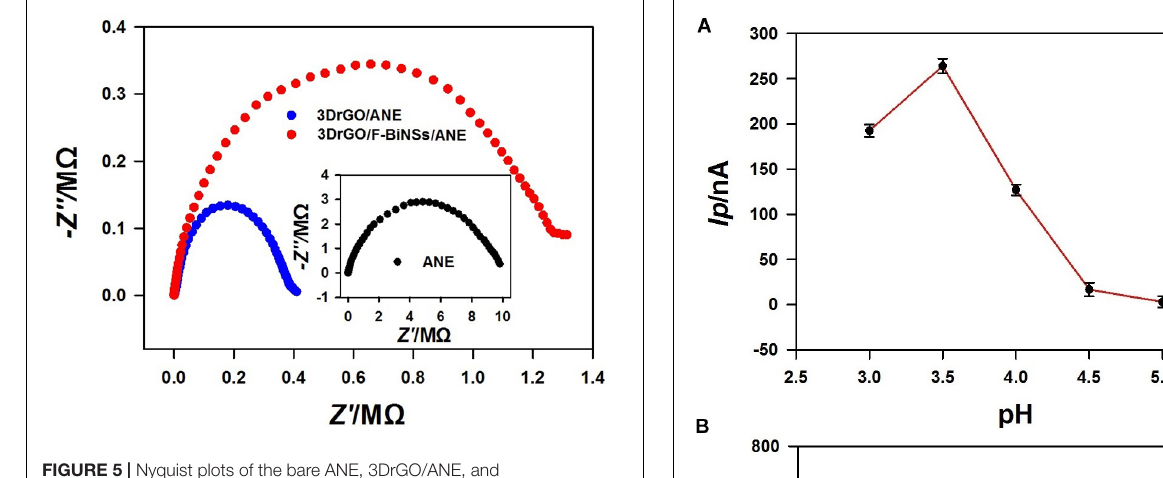
FIGURE 5 | Nyquist plots of the bare ANE, 3DrGO/ANE, and 3DrGO/F-BiNSs/ANE in 5 mmol L − 1 K 3 [Fe(CN) 6 ] solution (0.1 mol L − 1 KCl).